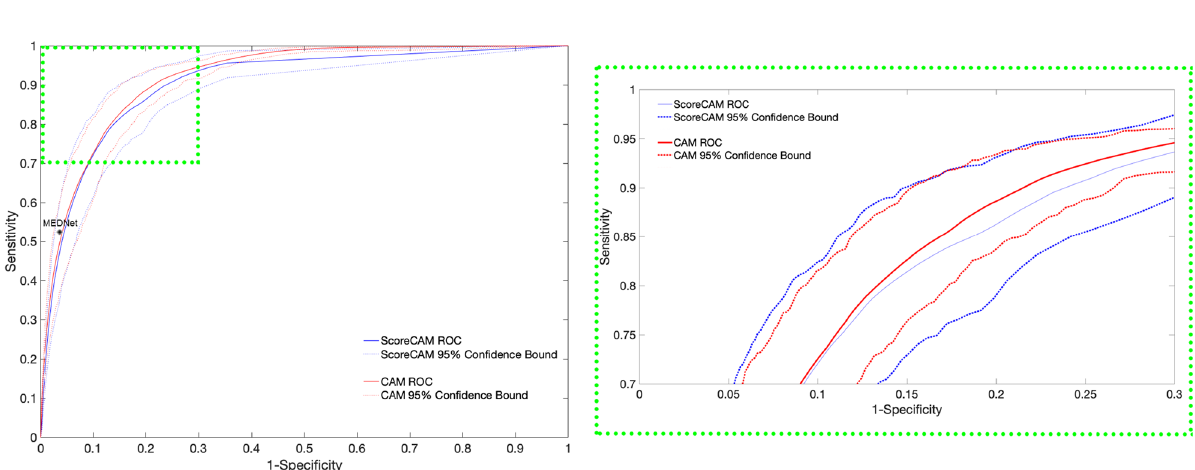
Figure 11. Comparison between the ROC of CAM and the ScoreCAM approaches. Solid line shows average ROC line of 1000 bootstrap runs and the dashed line shows the 95% confidence interval for the bootstrap experiments. For comparison, we also show the performance of the fully supervised approach, MED-Net 3 as a black dot in the graph in the left